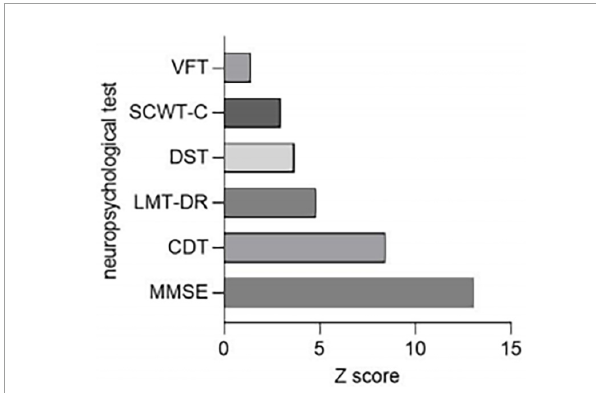
FIGURE2 Comparison of neuropsychological tests reduction rates between ESRD-BP ( n = 44) patients and HCs ( n = 46). CDT, clock drawing test; DST, digit span test; ESRD-BP, end-stage renal disease patients undergoing blood purification; HCs, healthy controls; LMT-DR, logical memory test-20-minutes delayed; MMSE, mini-mental state